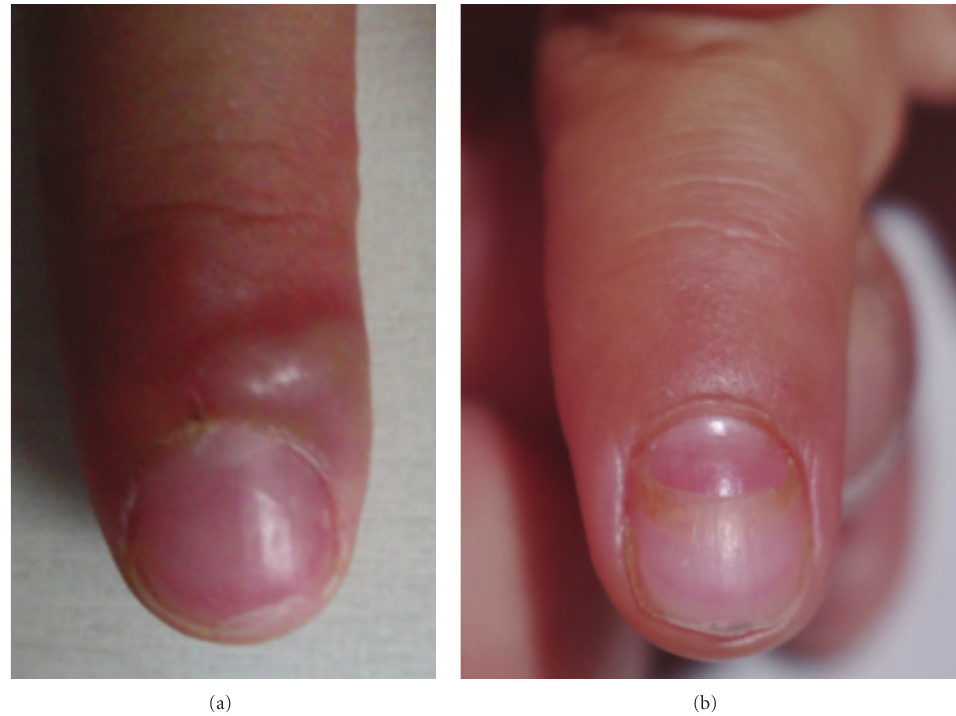
Figure 1: (a) A large pustule existed around the nail of the right index finger, looking like a herpetic whitlow. (b) At four weeks after the disappearance of cutaneous lesions of HFMD, onychomadesis appeared in the nail of the right index